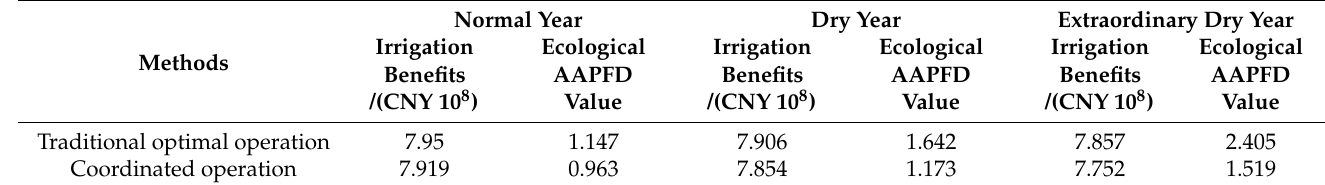
Table 5. Results of traditional optimal operation and coordinated operation for different typical years.